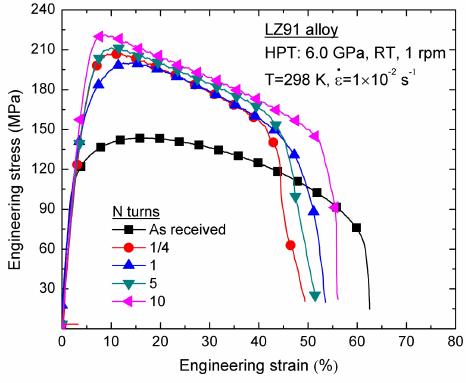
Figure 7. Engineering stress-engineering strain curves of LZ91 alloy before and after HPT processing through 1/4, 1, 5, and 10 turns at room temperature with an initial strain rate of 1 × 10 − 2 s − 1